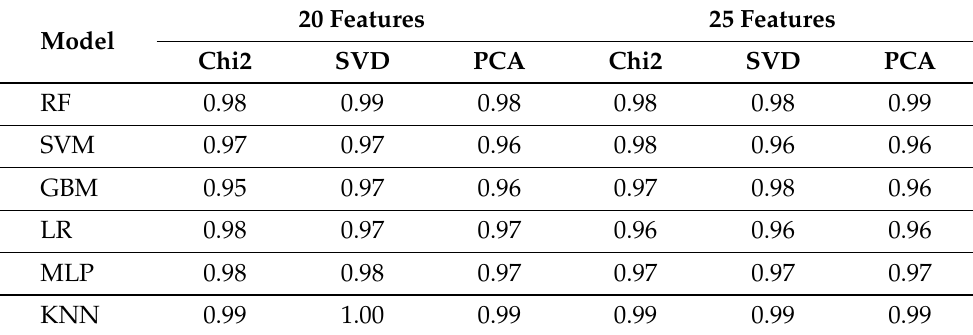
Table 12. Performance of classifiers with 20 and 25 most important features from a balanced dataset.